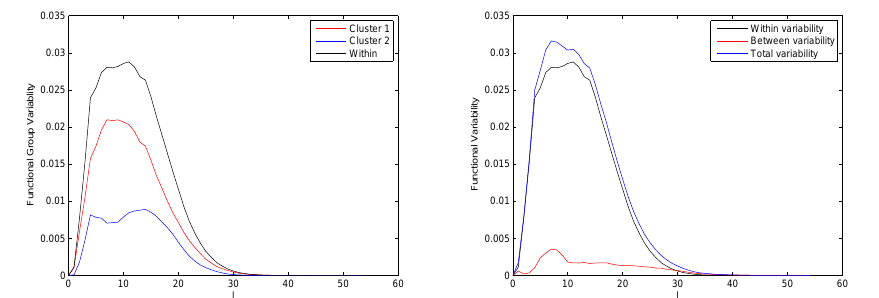
Figure 9 – Functional variabilityfor each group and functional within variability.